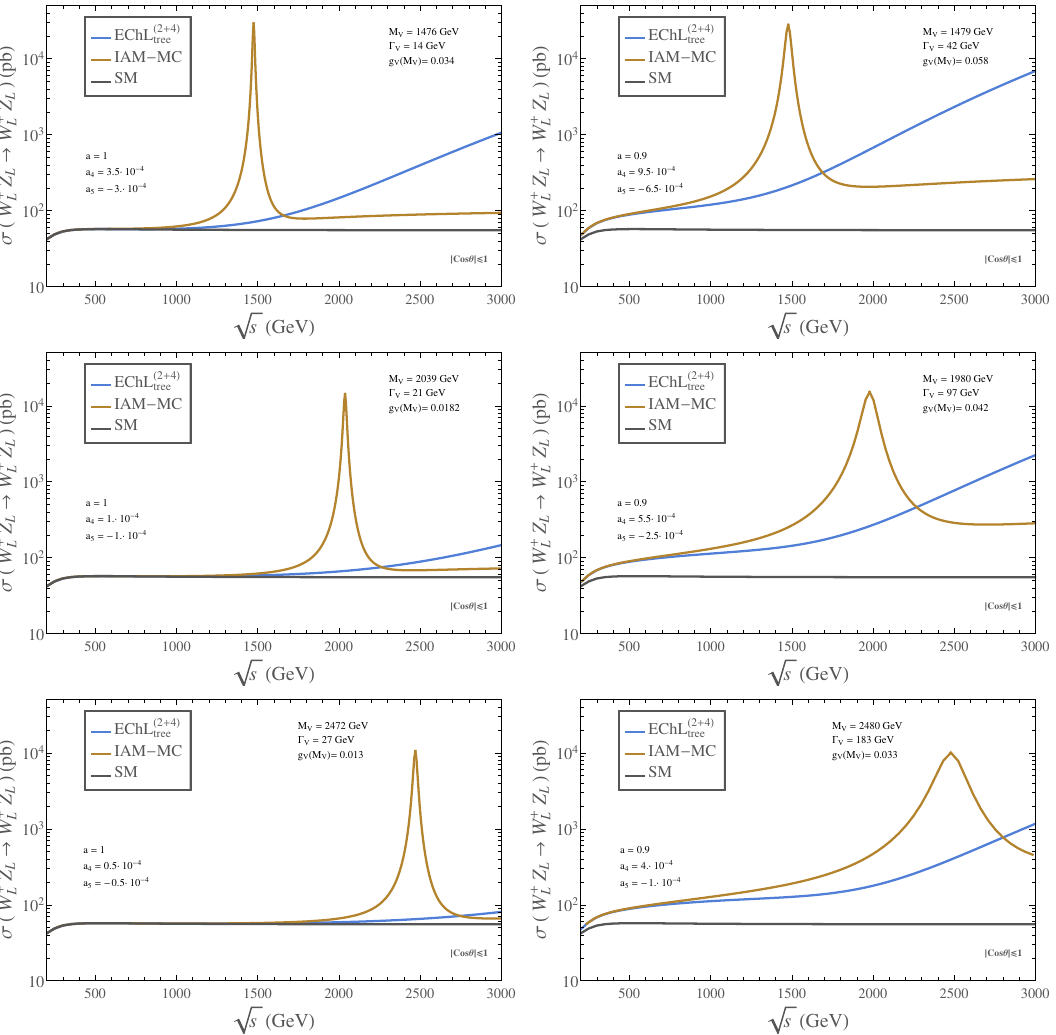
Figure 8 . Predictions of the cross section (cid:27) ( W + Z L W + Z L ) as a function of the center of mass L L ! energy p s for all the selected benchmark points in table 1 integrated over the whole center of mass scattering angle, cos (cid:18) 1. Di(cid:11)erent lines correspond to the di(cid:11)erent models considered in the j j (cid:20) text: SM (black), our IAM-MC model (orange) and non-unitarized EChL up to ( p 4 ) O